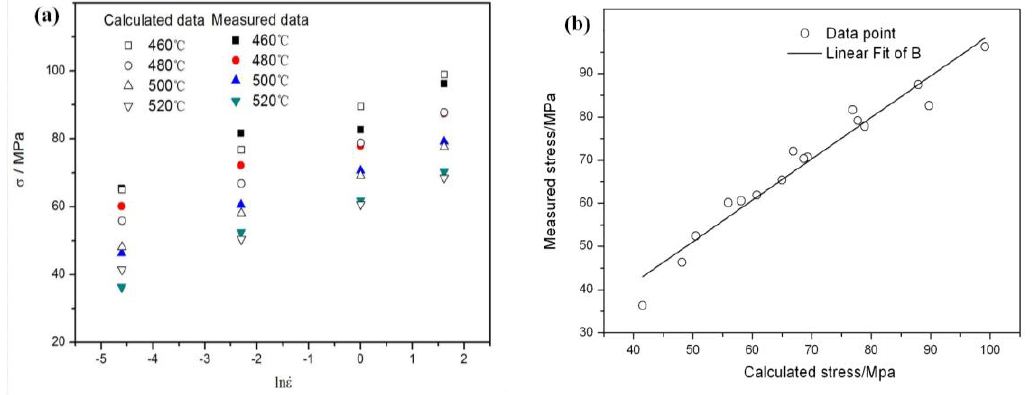
Figure 6. ( a ) The comparison and ( b ) Correlation between the calculated and measured values of peak stress for the dual-scale SiCp/A356 composites.